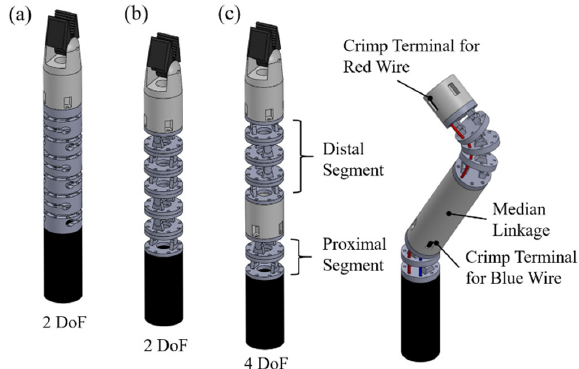
Figure 2. Structure of snake-like surgical robotic arms: ( a ) single segment with slit structure; ( b ) single segment with joint structure; ( c ) double segment with joint structure.